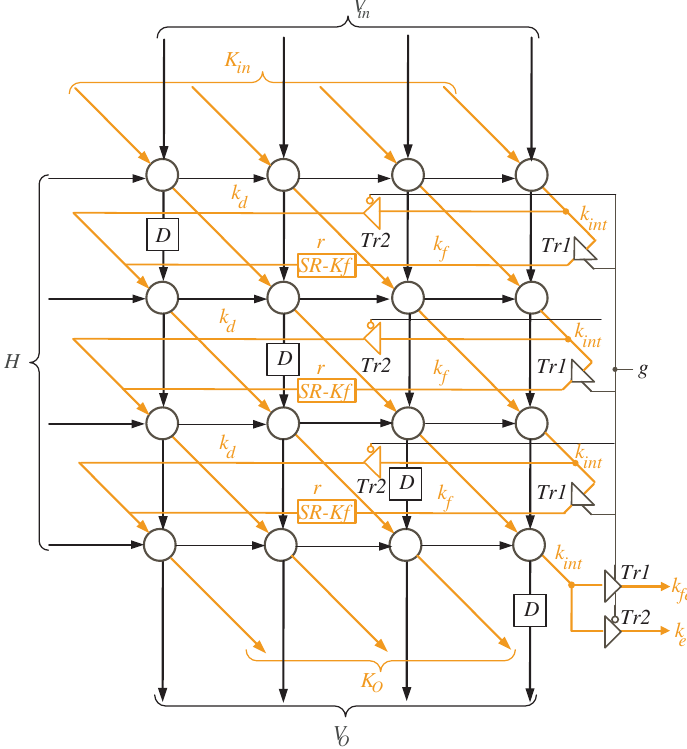
Figure 5. The structure of Multiplier SISO processor array.